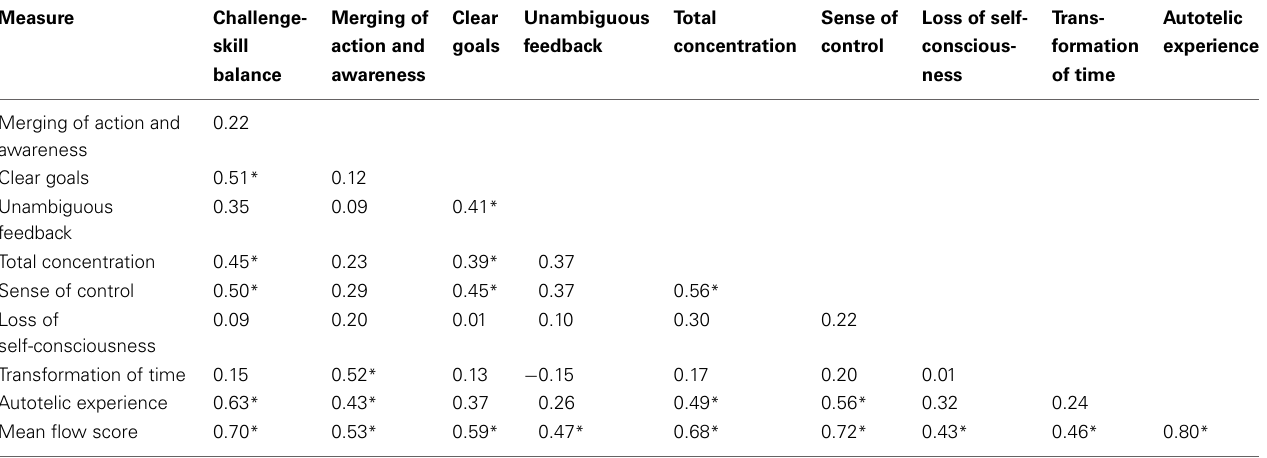
Table 2 | Spearman-Rho correlations between the global mean DFS-2 score and the mean scores of the nine flow subscales ( N = 76). Measure Challenge- Merging of Clear Unambiguous Total Sense of Loss of self- Trans- Autotelic skill action and goals feedback concentration control conscious- formation experience balance awareness ness of time Merging of action and 0.22 awareness